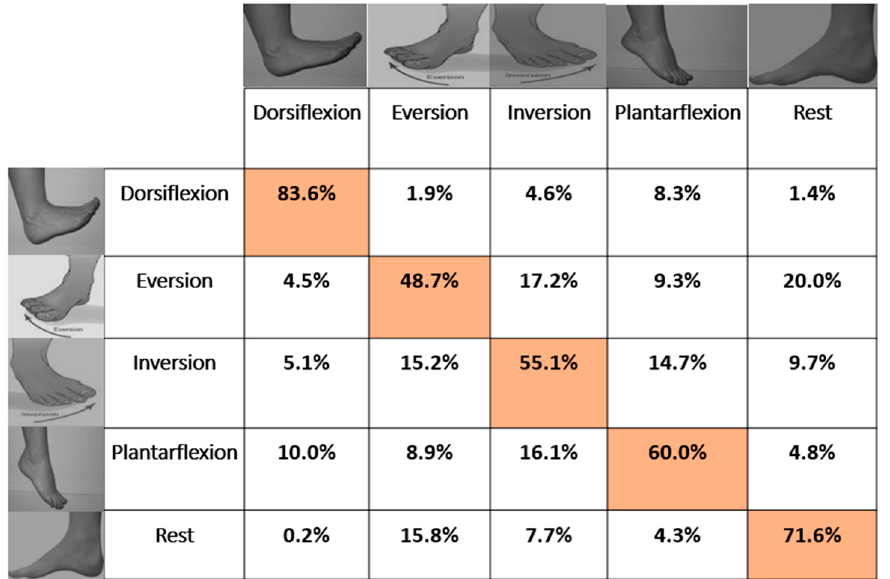
Figure 5. Confusion matrix based on the average classification accuracies of all subjects for LDA with overall average accuracy of 63.86% ± 4.3%. The Highlighted boxes represents the correct percentage of predictions made by the classifier.